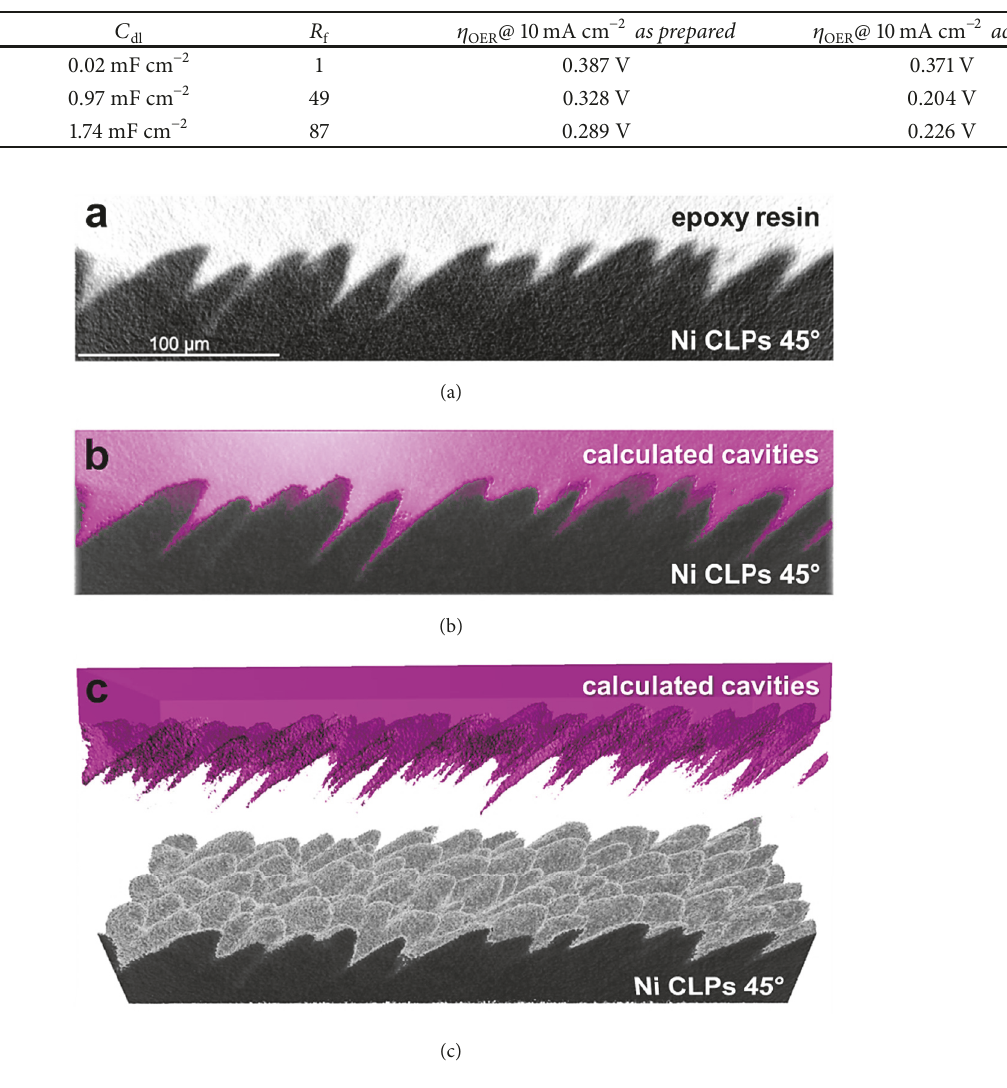
Figure 4: X-ray microscopy (XRM) data showing ( a ) absorption-contrast image of Ni CLPs 45 ∘ and representative density information. Reconstruction of the cavities within the Ni CLPs 45 ∘ structure based on absorption contrast of infiltrated epoxy resin in 2D ( b ) and 3D visualization ( c